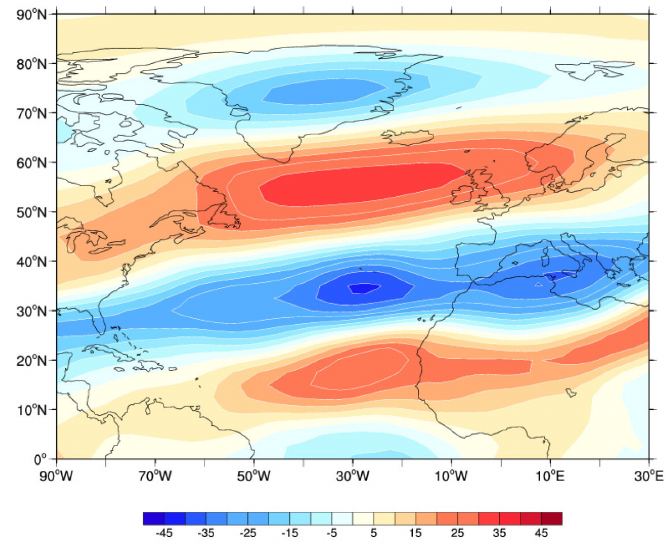
Figure 6. Distribution of zonal wind anomalies (m · s − 1 ) at 200 hPa (anticyclonic wave breaking period (14 January to 3 February 2008) minus cyclonic wave breaking period (24 December 2009 to 13 January